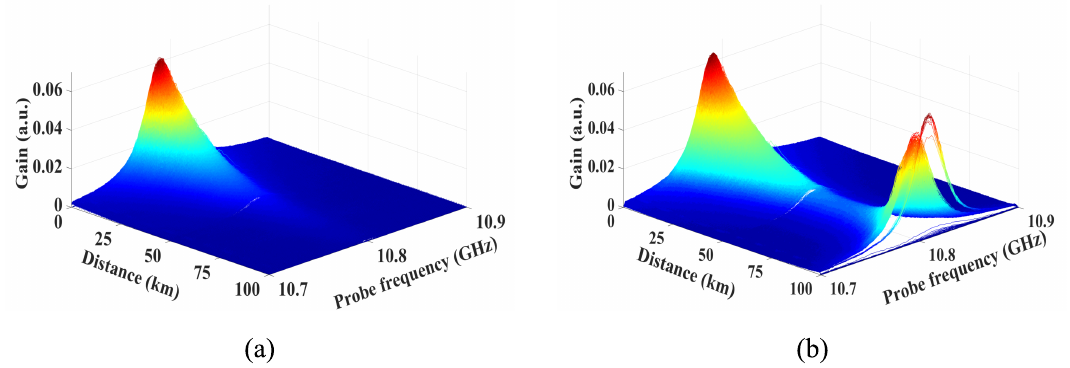
Figure 5. Brillouin gain distribution measured with ( a ) dual-probe-sideband BOTDA sensor using frequency modulation of the probe wave and ( b ) novel BOTDA with pulse amplification. A pulse duration of 45 ns was deployed in both measurements. (From Juan José Mompó, Javier Urricelqui, and Alayn Loayssa, “Brillouin optical time-domain analysis sensor with pump pulse amplification”, Opt. Express 2016 , 24 , 12672–12681. With permission. Copyright 2016 Optical Society of